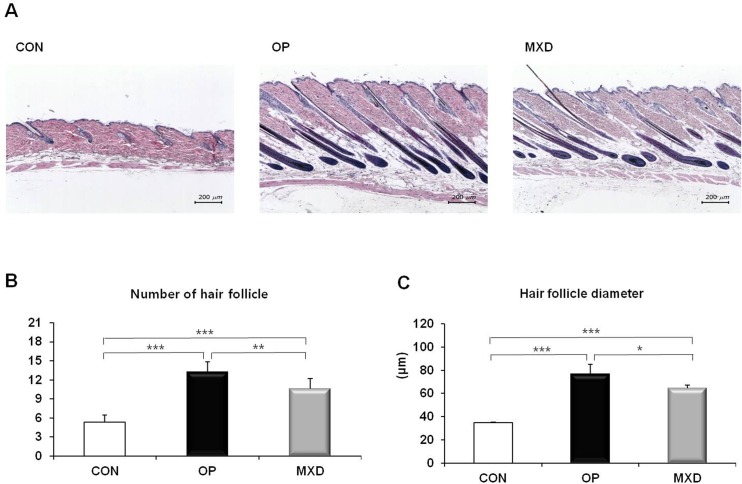
Effect of oleuropein on hair follicle growth in C57BL/6N mice.The CON, 0.4 mg/mL OP, or 3 mg/mL MXD was topically applied to the shaved back skin of C57BL/6N mice for 28 days. (A) The effect of oleuropein on the hair follicles of the mice was analyzed by using hematoxylin and eosin staining. Longitudinal sections of the back skin were stained, and representative photomicrographs of skin sections are shown. Bars, 200 μm. Number (B) and diameter (C) of hair follicles in deep subcutis. Values are the mean ± SD of eight mice. * = p < 0.05, ** = p < 0.01, *** = p < 0.001 (one-way ANOVA, Tukey's test).